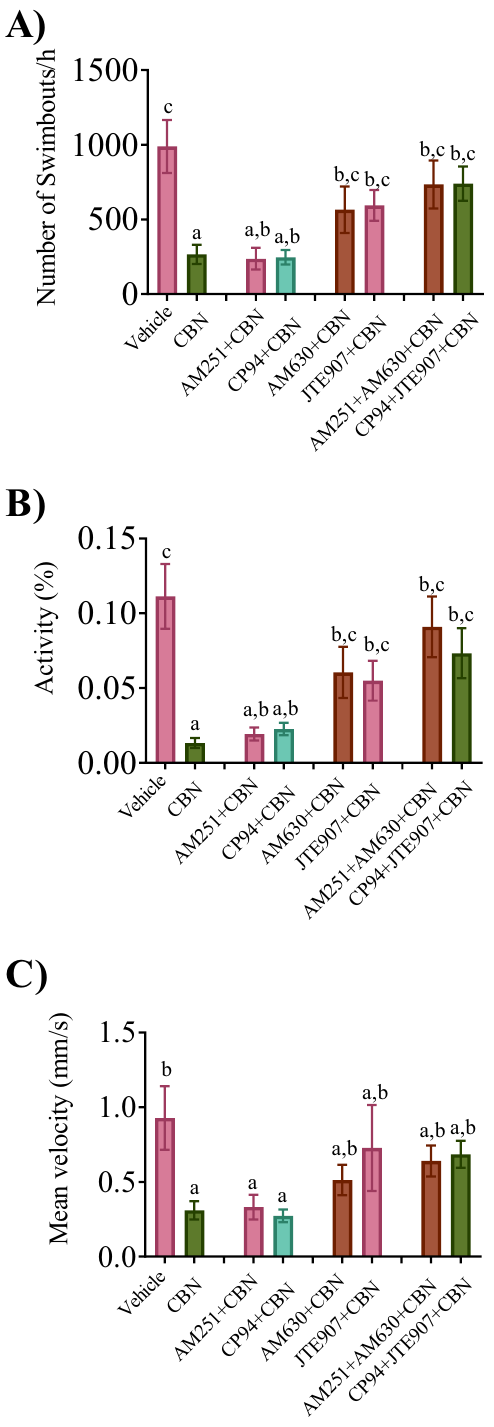
Figure 5. Combined exposure of Cb2r with CBN prevents the CBN-induced deficits in locomotion. The free swimming movement of the fish was recorded for 60 min and the recorded video was analyzed later. Tracing was recorded at 5 dpf for vehicle control (n = 18), 3 mg L −1 CBN (n = 25), AM251 10 nm + 3 mg L −1 CBN (n = 37), CP94 10 nm + 3 mg L −1 CBN (n = 31), AM630 10 µm + 3 mg L −1 CBN (n = 32), JTE907 10 µm + 3 mg L −1 CBN (n = 37), AM251 10 nm + AM630 10 µm + 3 mg L −1 CBN (n = 36) and Cp94 10 nm + JTE907 10 µm + 3 mg L −1 CBN (n = 40) respectively. N = 4 experiments. ( A ) Bar graph shows the mean frequency of swim bouts within 1 h. ( B ) Bar graph shows the mean swimming activity (%) in 1 h. ( C ) Bar graph shows the mean swimming velocity (mm s −1 ) over a 1 h time period. Groups which share the same letter(s) of the alphabet are not statistically different from one another; p <